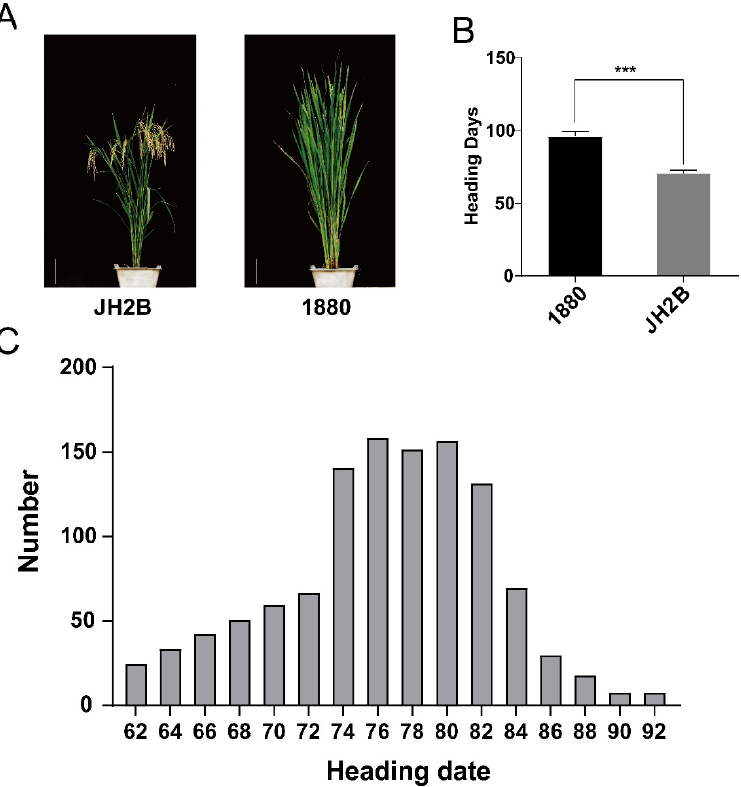
Figure 1. Genetic analysis of heading date in 1880 and JH2B. ( A ) The phenotype of the 1880 and JH2B for heading date. Scale bars = 5 cm; ( B ) Statistics on the heading date of 1880 and JH2B; Values are means ± SD (n = 5), *** indicates a significant difference at p < 0.001 by t-test;( C ) Distribution of heading date in the F 2 population derived from 1880 × JH2B.